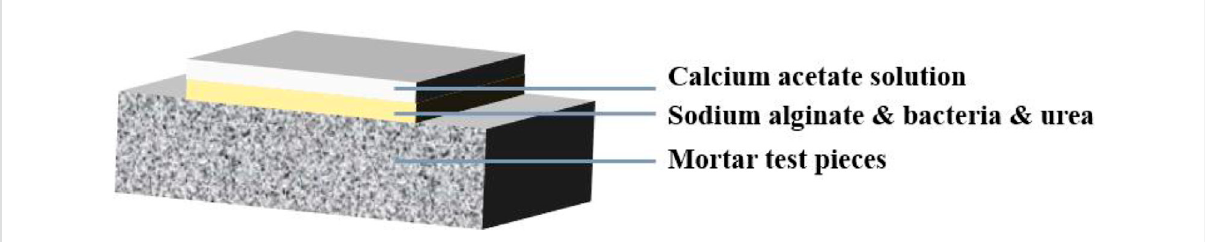
FIGURE 2 Repair application method at cracks in mortar surfaces.